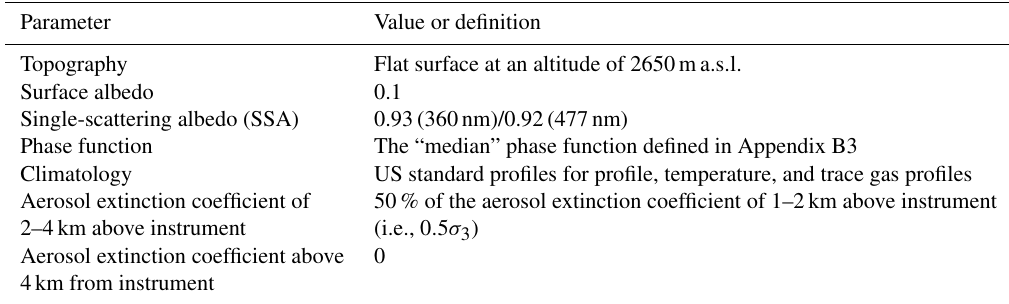
Table 5. Settings of fixed parameters in calculating the O 4 DSCD lookup